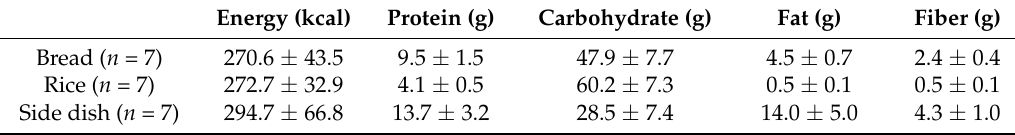
Table 2. Nutritional composition of bread, rice and side dish per one meal.